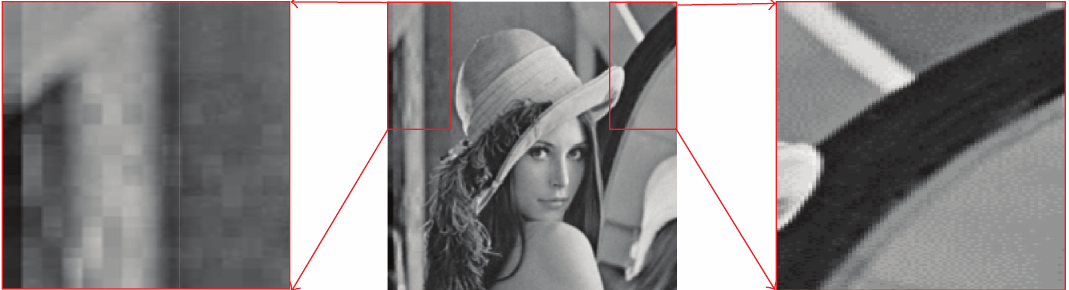
Figure 5: Illustration of visible distortion caused by embedding the watermark by zooming the portions of watermarked image.